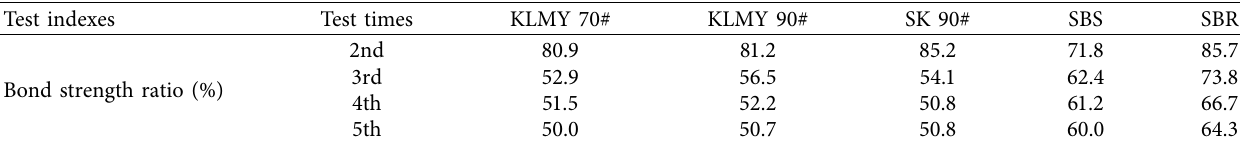
Table 12: Calculation results of bond strength self-healing